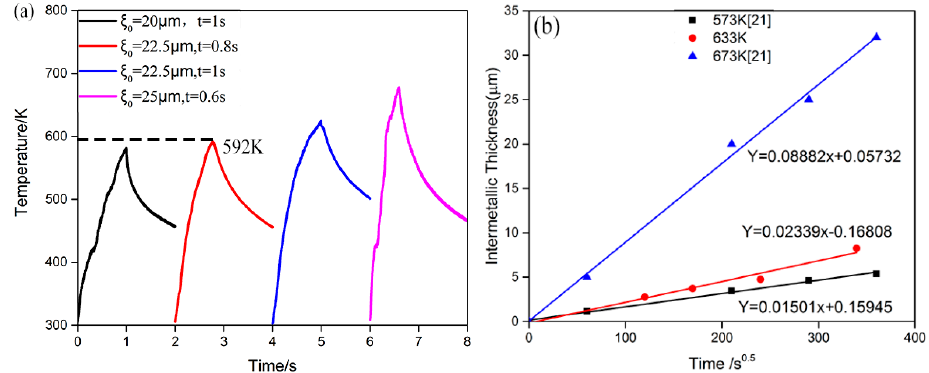
Figure 4. ( a ) Interfacial temperature measured during ultrasonic spot welding (USW) for various amplitudes; ( b ) Changes in the intermetallic layer thickness with the annealing time and temperature.